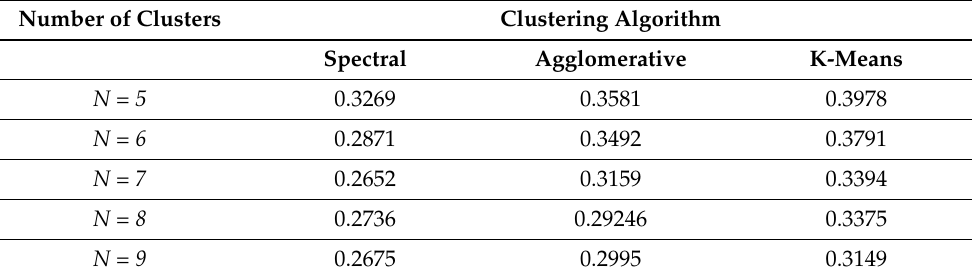
Table 4. Obtained silhouette coefficients for feature-selected variables.